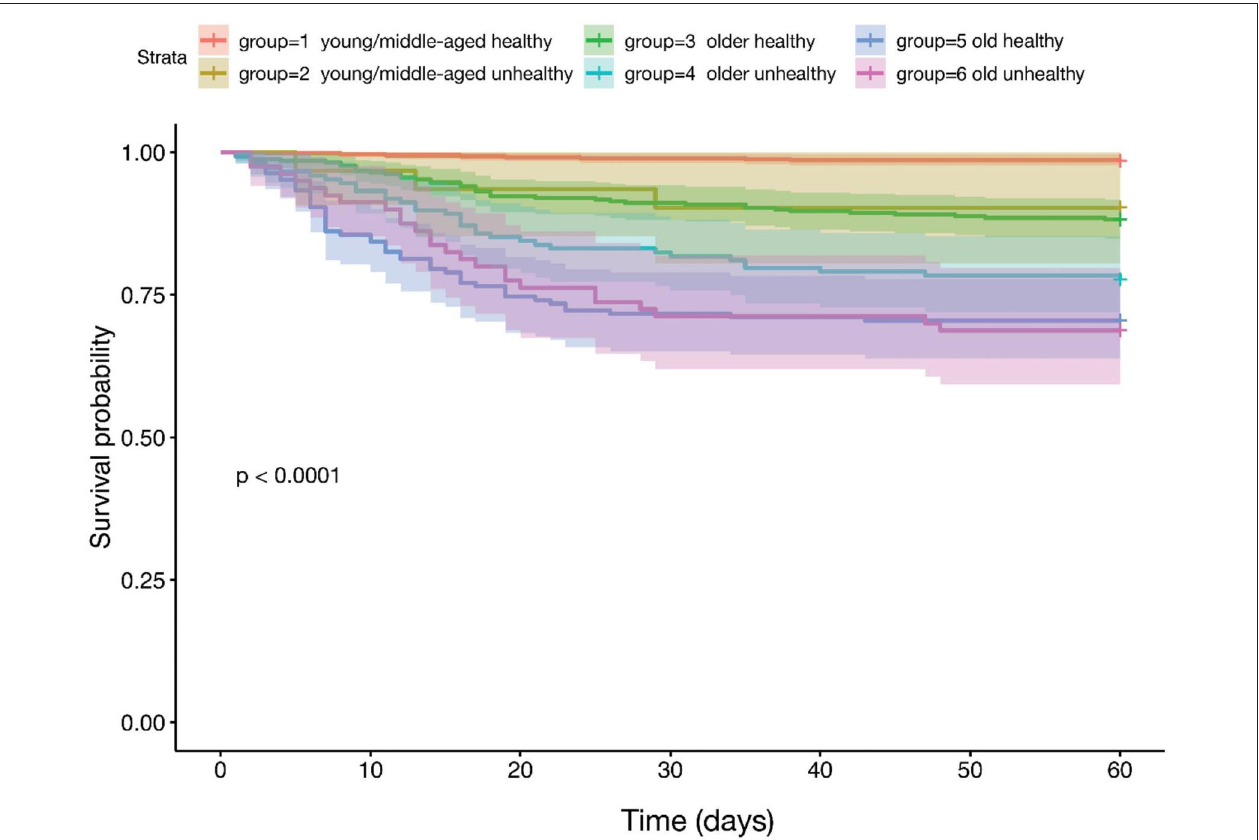
FIGURE 3 | Kaplan-Meier survival comparing three age groups based on the presence (unhealthy) or absence (healthy) of obesity, diabetes and hypertension. All COVID-19 patients who recovered and died ( n = 3,163) were first divided in three age groups (young and middle aged, 18–55 years, n = 1,068; older age, 56–75 years; n = 1,220 and old age, > 75 years; n = 875) and subsequently divided in two groups ( n = 1,357) based on the presence (unhealthy) or absence (healthy) of obesity (BMI ≥ 30 kg · m − 2 ), and impaired metabolic health (diabetes and